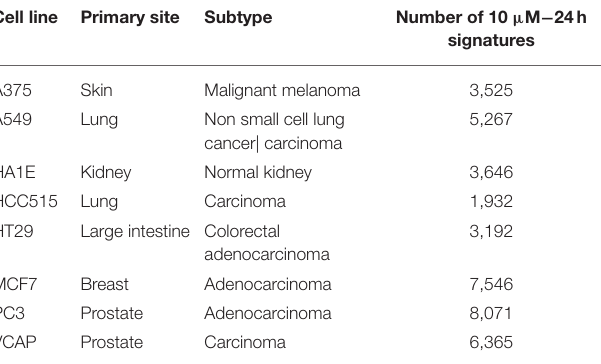
FIGURE 1 | Data analysis pipeline performed in current work. Starting from the CMAP L1000 dataset, signatures produced at 10 µ M and 24h from 8 cell lines were extracted and used in t-SNE and distance plots. One dataset was built per cell line (GES and corresponding compound structure), and each of these datasets were restricted to compounds having known annotations (active or inactive) for the evaluated target. For each target—cell line dataset, a first model was built using the gene expression signatures (GES model). Alongside, a second counterpart model was built using the Morgan fingerprints of compounds whose signatures were used in the first model (Morgan FP model). TABLE 1 | The 8 core cell lines used in this work, with their corresponding number of GESs for compounds with known structure tested at 10 µ M/24h. Cell line Primary site